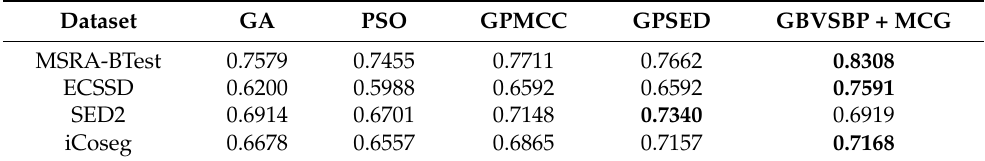
Table 20. Comparison with others models and databases published in [6]. Our proposal achieves better results than the more complex proposal using compound